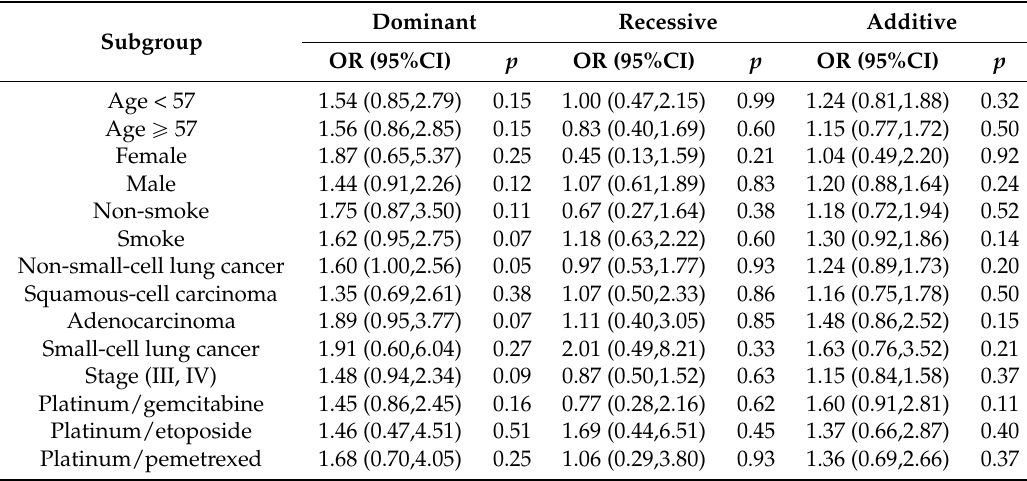
Table 6. Stratification analysis of association between CASC8 rs10505477 and response of platinum-based chemotherapy in lung